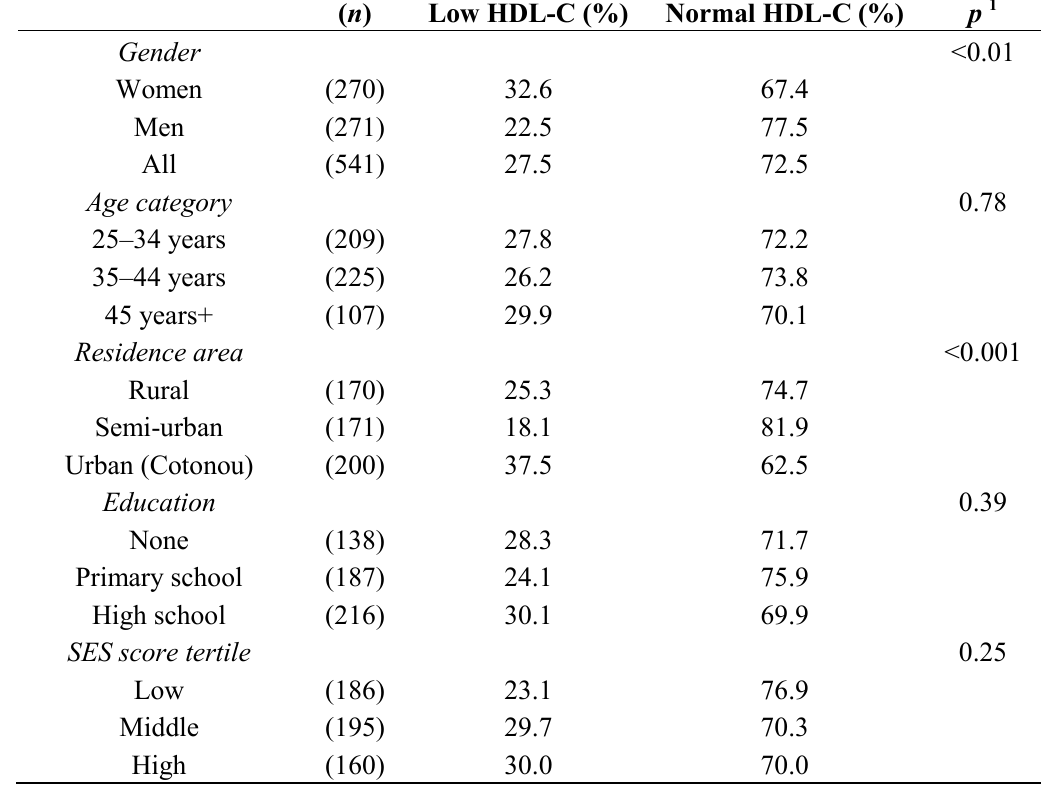
Table 1. Subjects’ characteristics according to high-density lipoprotein cholesterol (HDL-C)